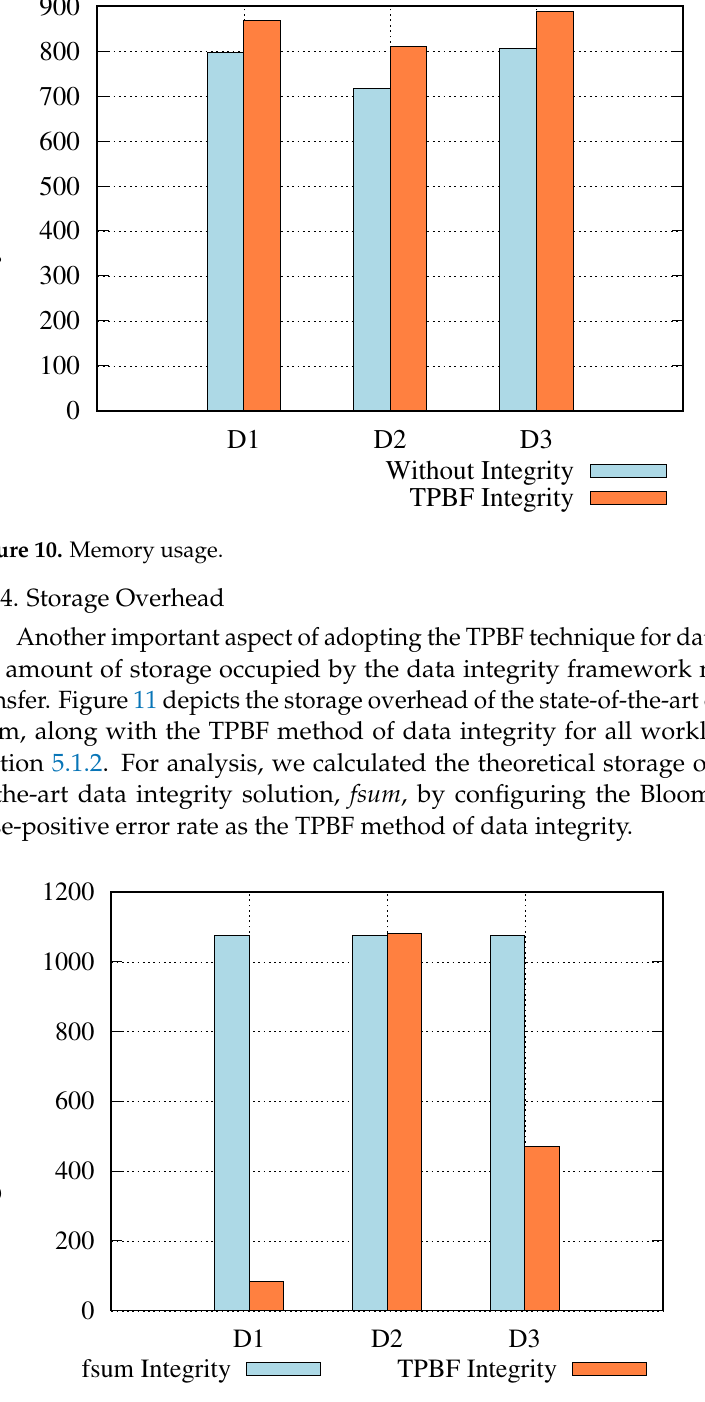
Figure 11. Storage overhead comparison of fsum and